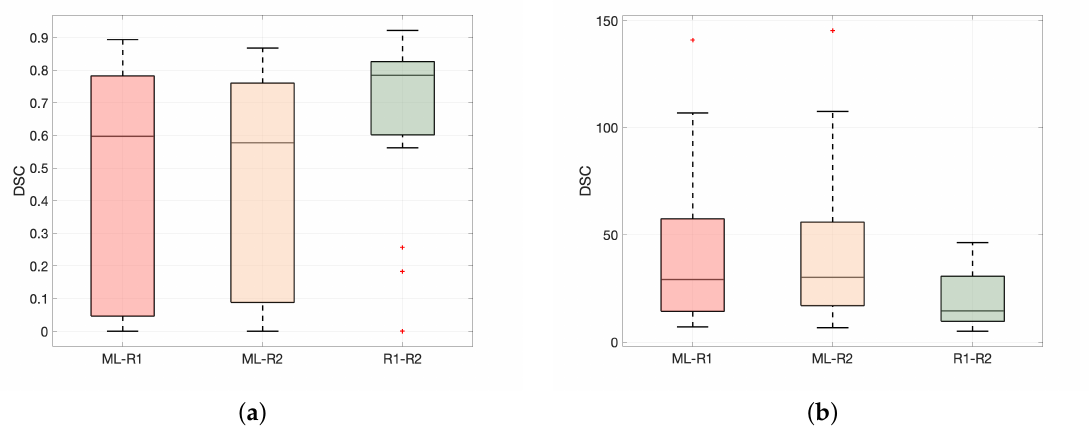
Figure 5. Comparison of ( a ) Median Dice coefficient (DSC) and ( b ) Median Hausdorff distance (HD) for segmentations by DL-R1, DL-R2, and R1-R2. Agreement between R1-R2 is significantly better than between DL and R1/R2 in terms of DSC and HD (Wilcoxon rank sum test, p ≤ 0.01). The central line indicates the median, and the upper and edges of the box indicate the 25th and 75th percentiles, respectively. The whiskers indicate the most extreme data points not considered to be outliers, while outliers are plotted individually using a ‘+’ symbol. R1 = rater 1; R2 = rater